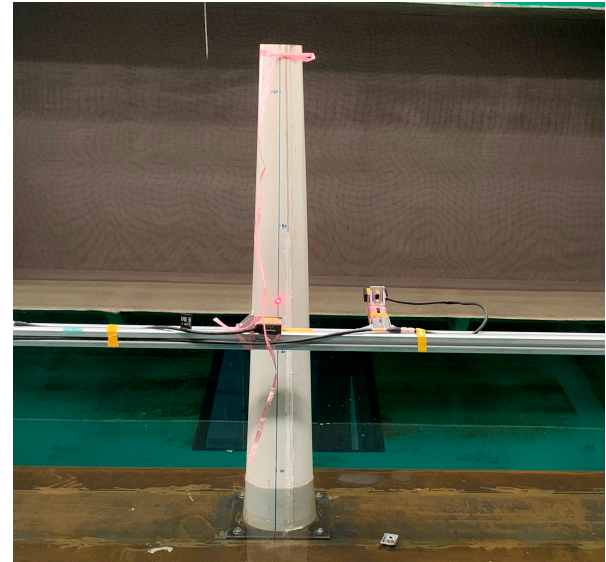
Figure 1. Experimental setup of the tower model.